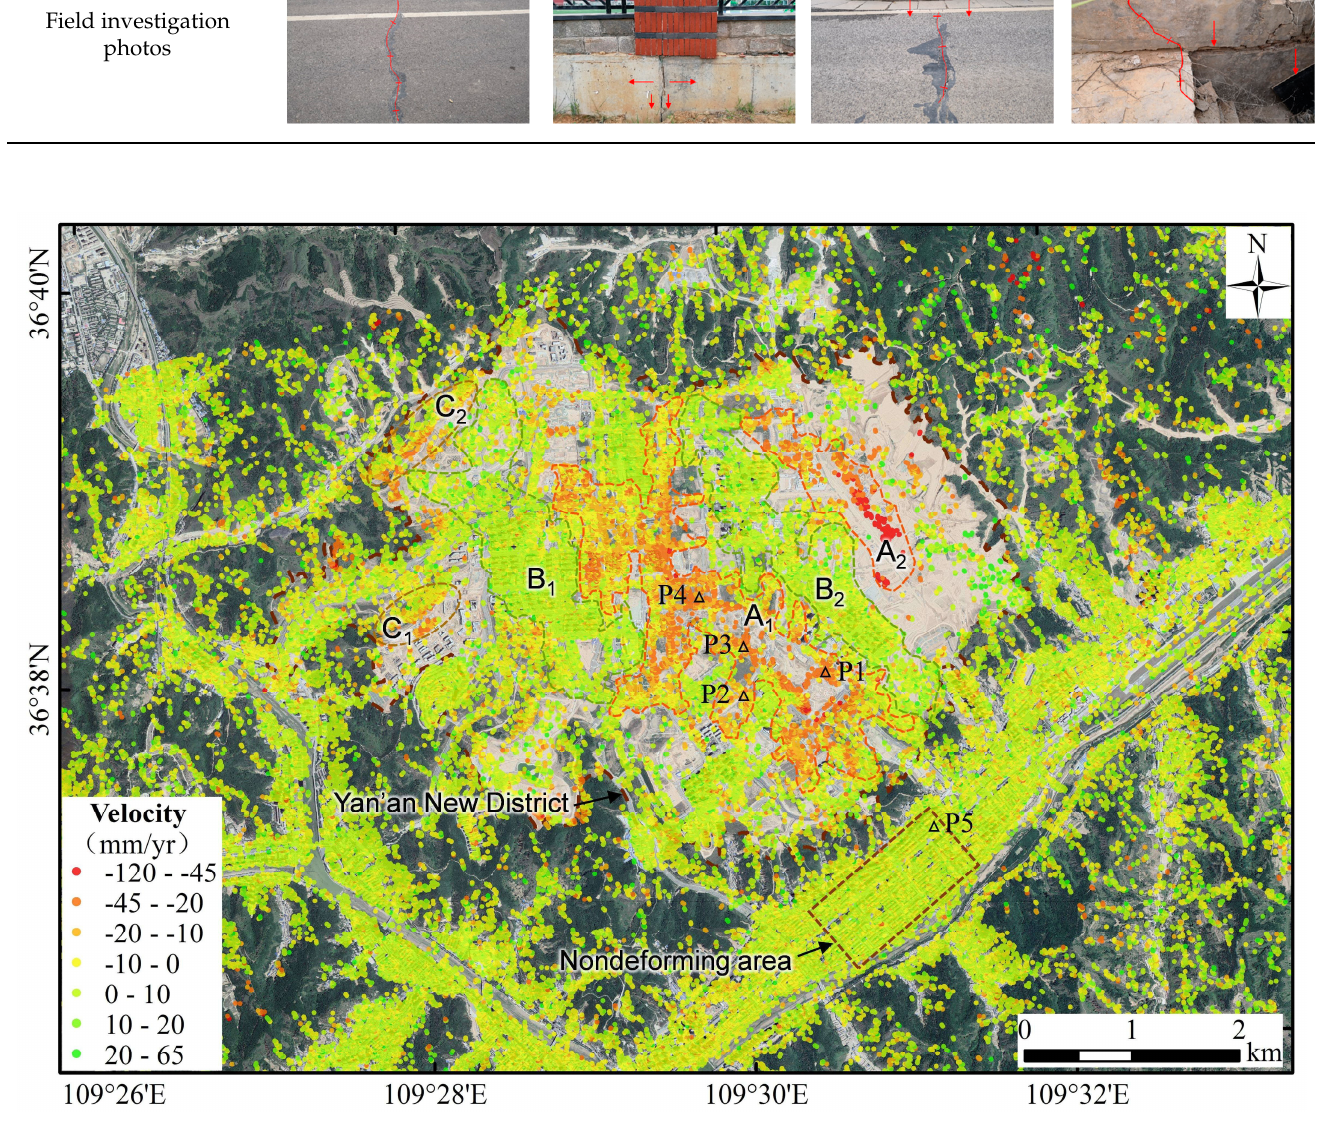
Figure 6. Annual deformation rates in the Yan’an New District. The dashed line outlines the main deformation area. The black triangles correspond to the four typical sample areas used in the field surveys and the time series analysis (see Table 3 and Figure 7). Table 3. Examples of the ground deformation characteristics obtained from the field survey.